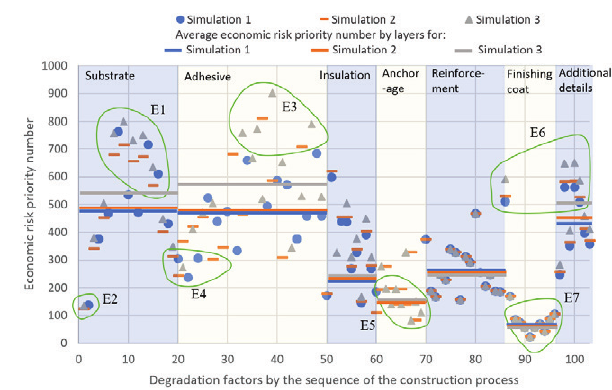
Figure 9. Economic risk priority number of the degradation factors by the sequence of the construction